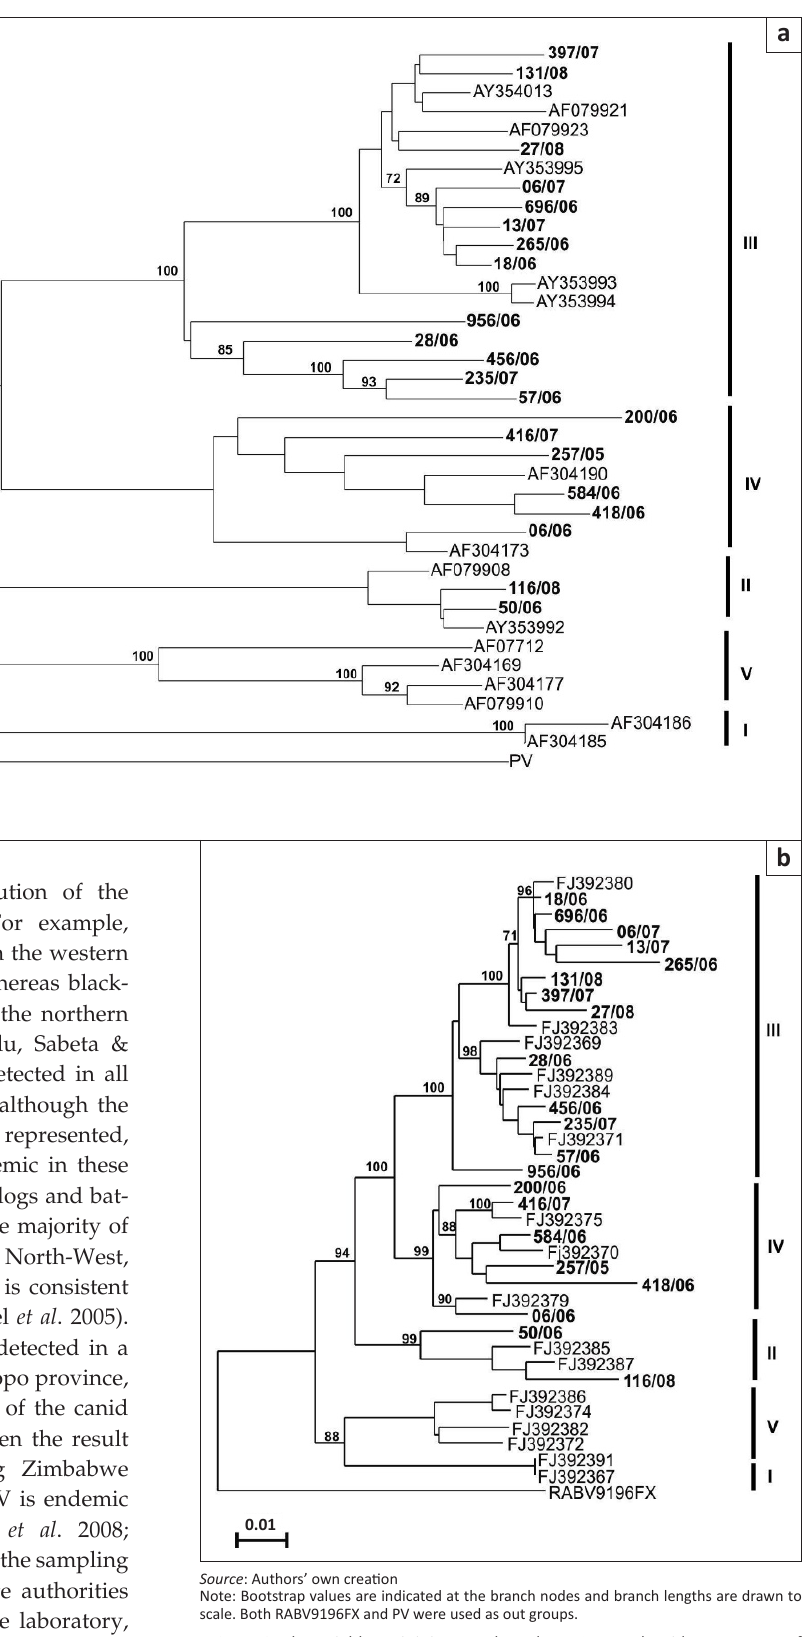
FIGURE 2: The neighbour-joining tree based on 1353 nucleotide sequences of nucleoprotein (a) and 592 nucleotide sequences of the G-L intergenic region (b) of the 21 mongoose rabies viruses selected from antigenic